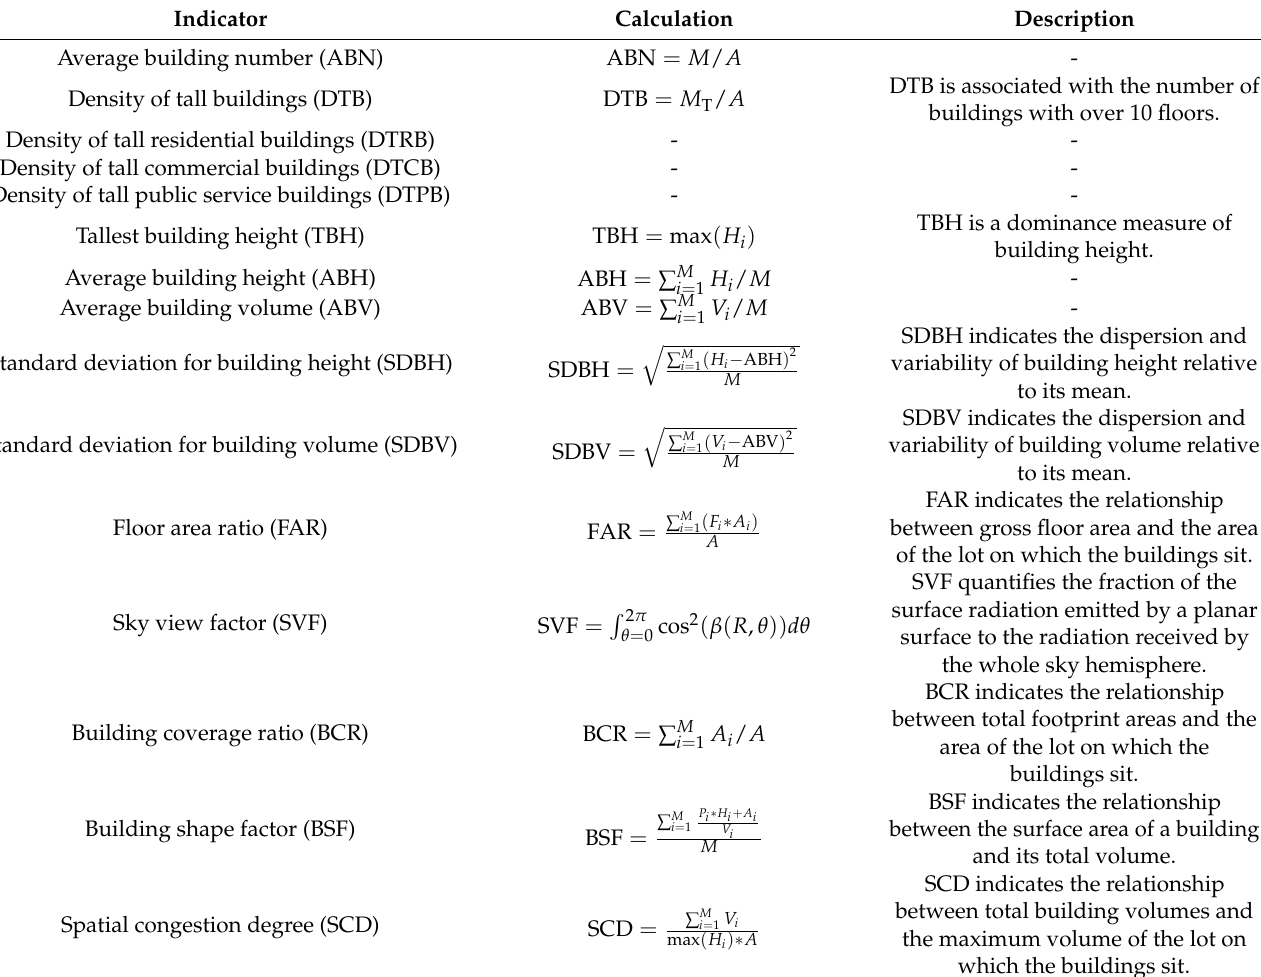
Table 1. Information about three-dimensional spatial